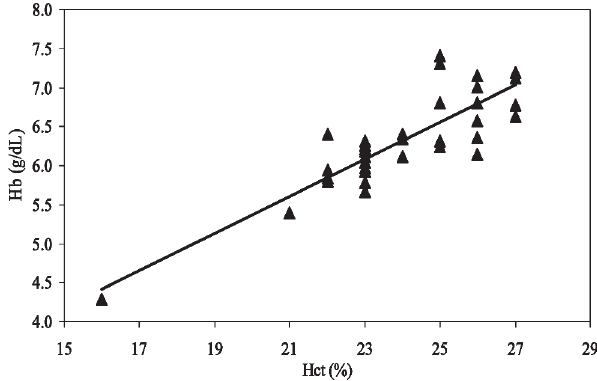
Fig. 2. Relationship between red blood cells ( r = 0.938; p<0.001) and hemoglobin concentration in C . temensis (n = 40) farmed in central Amazon.